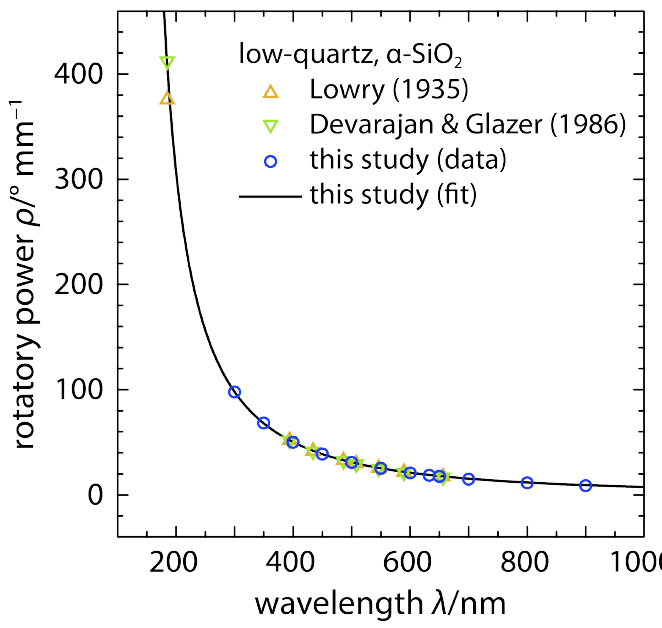
Figure 2. Optical rotatory dispersion of low-quartz, α -SiO 2 . Lowry (1935): measurements [43]; Devarajan & Glazer (1986): calculation [44]; this study: measurements and fit to